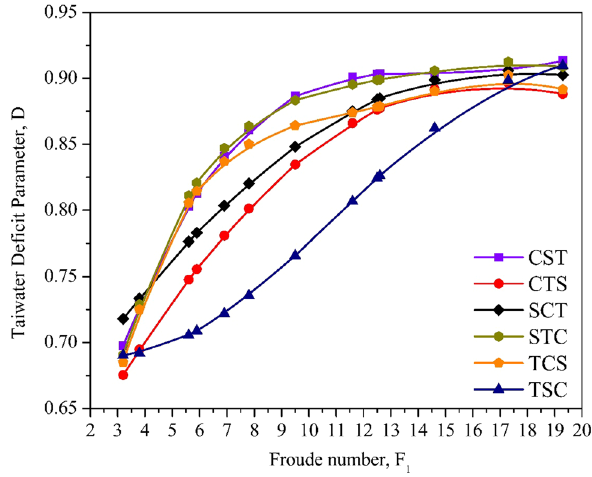
Fig. 8 Parameter D vs Froude number ( F